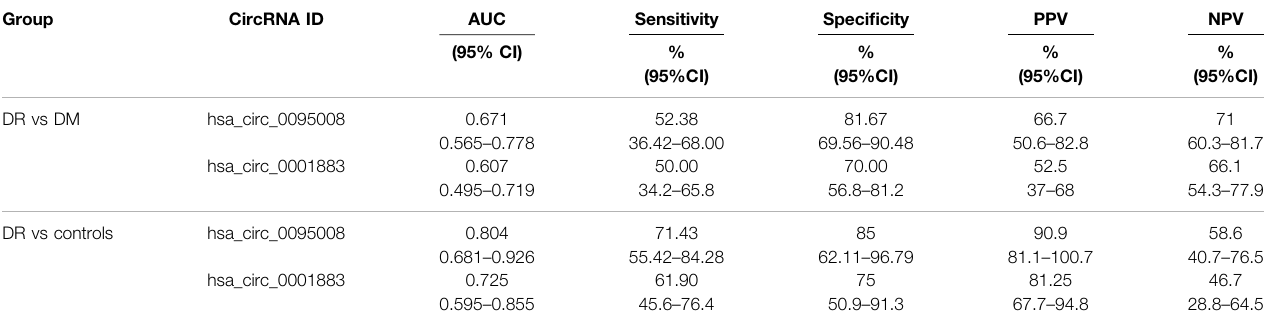
TABLE 4 | AUC characteristics of hsa_circ_0095008 and hsa_circ_0001883.